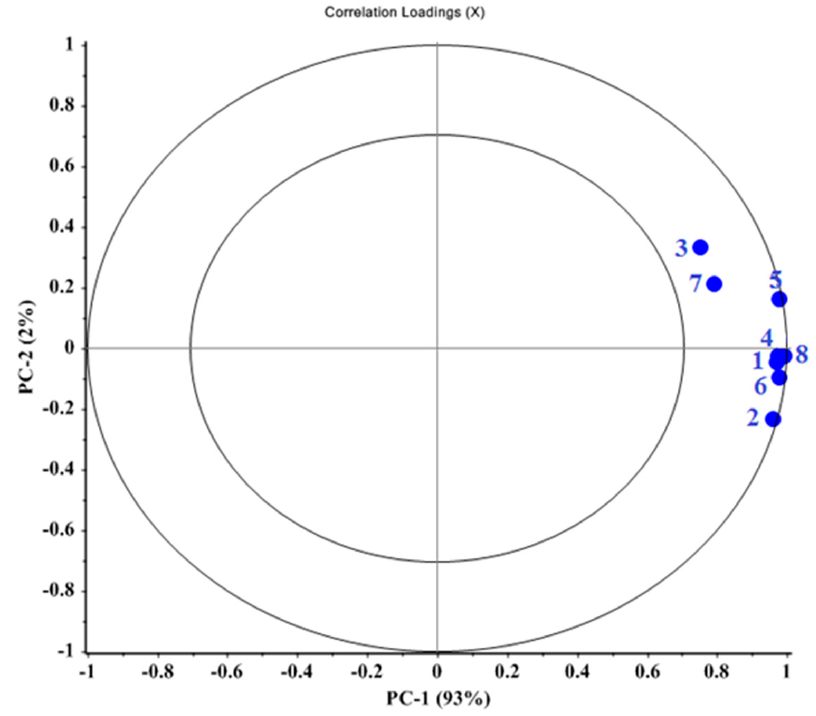
Figure 5. Loading plot for PCA analysis for different levels of urea fertilizer.